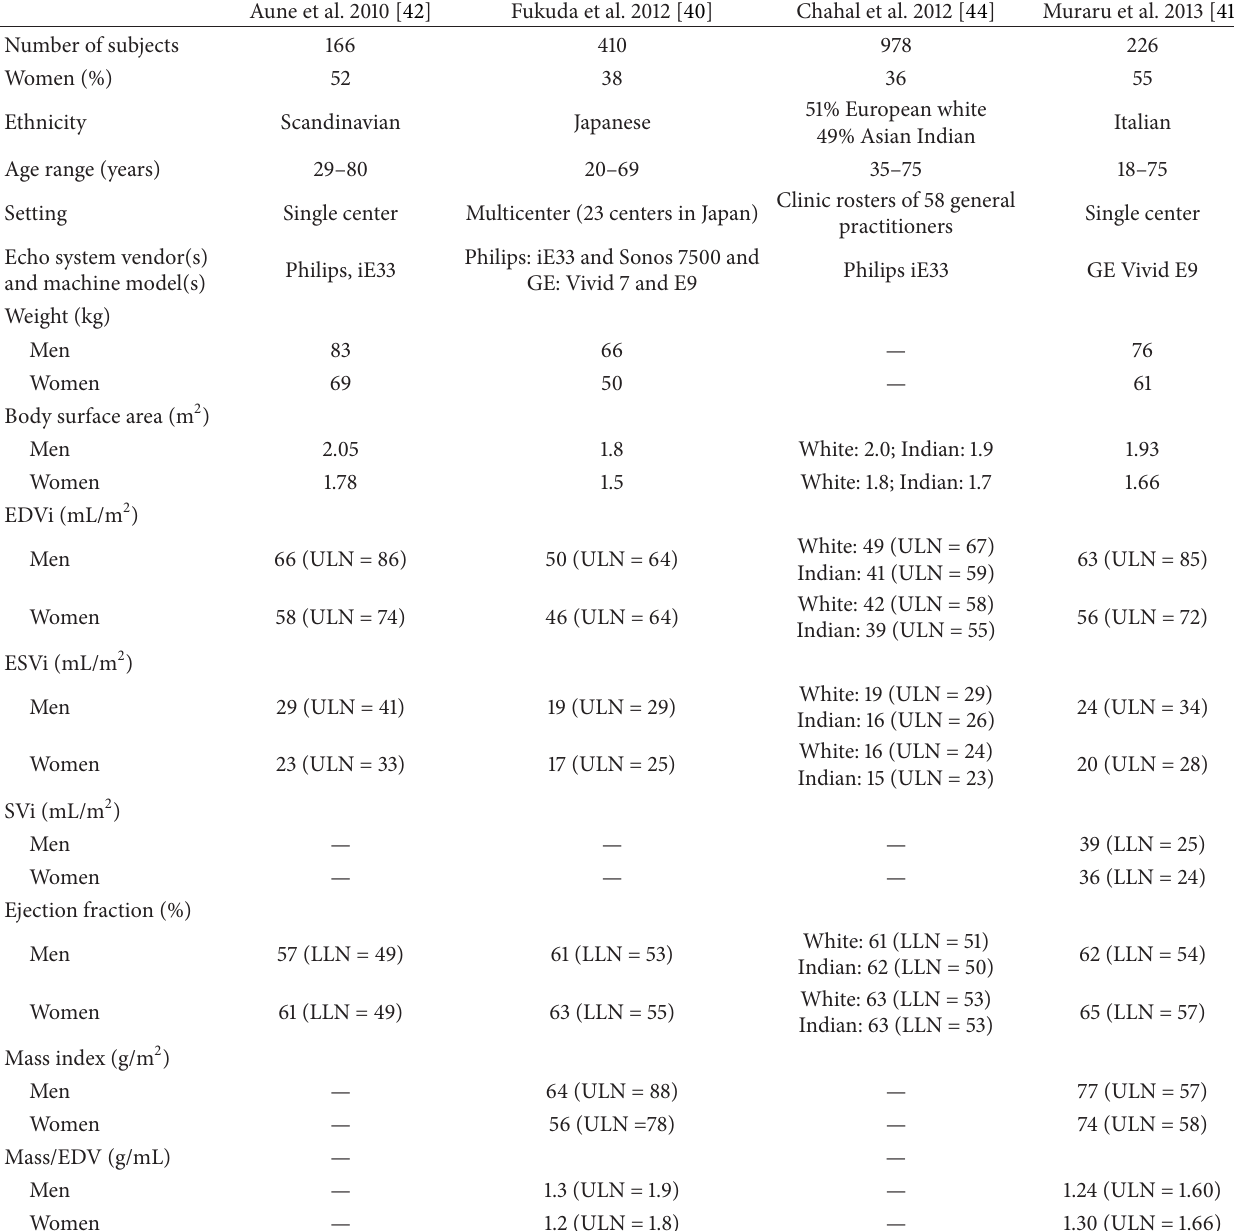
Table 4: Published reference values for three-dimensional echocardiography derived left ventricular geometry and function